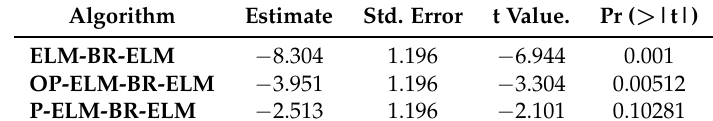
Table 10. Multiple Comparisons of Means: Dunnett Contrasts.